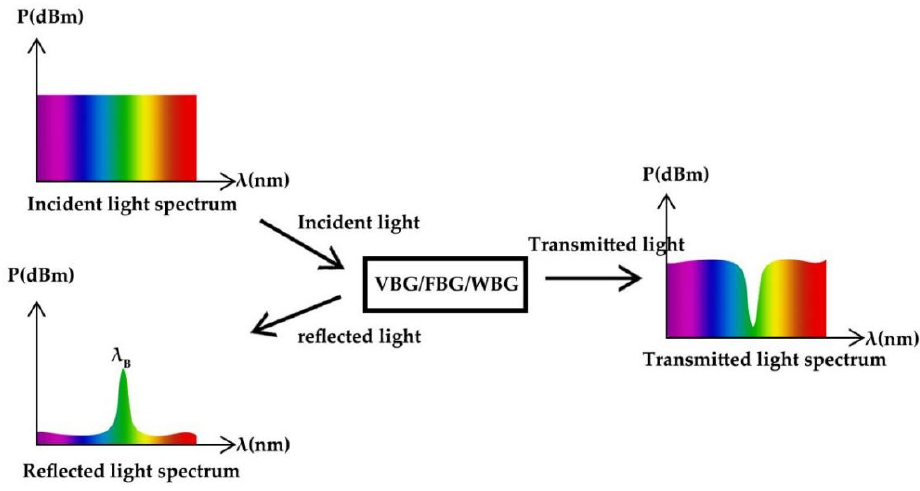
Figure 2. Bragg grating reflection principle.